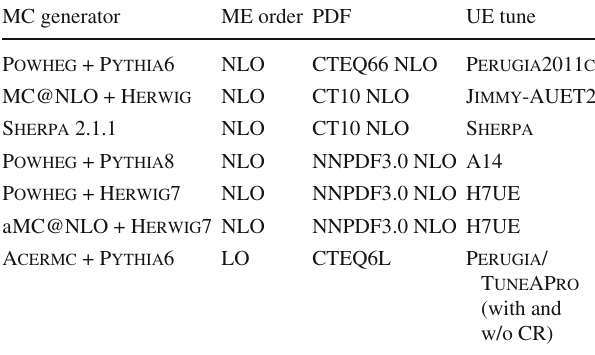
Table 1 Summary of basic generator settings used to simulate the t ¯ t